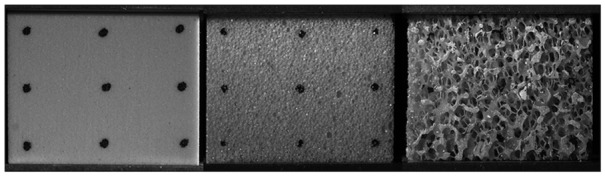
Representative sample images for solid polyurethane (S, left), cellular
polyurethane (C, centre) and open urethane–epoxy composite (O, right) foam
types.